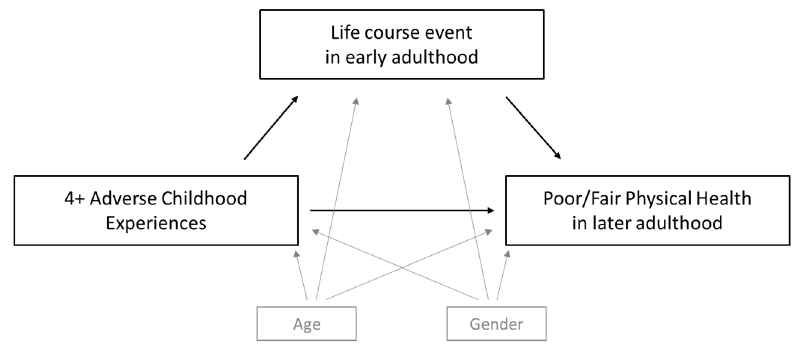
Figure 1. Directed acyclic graph of mediation model.